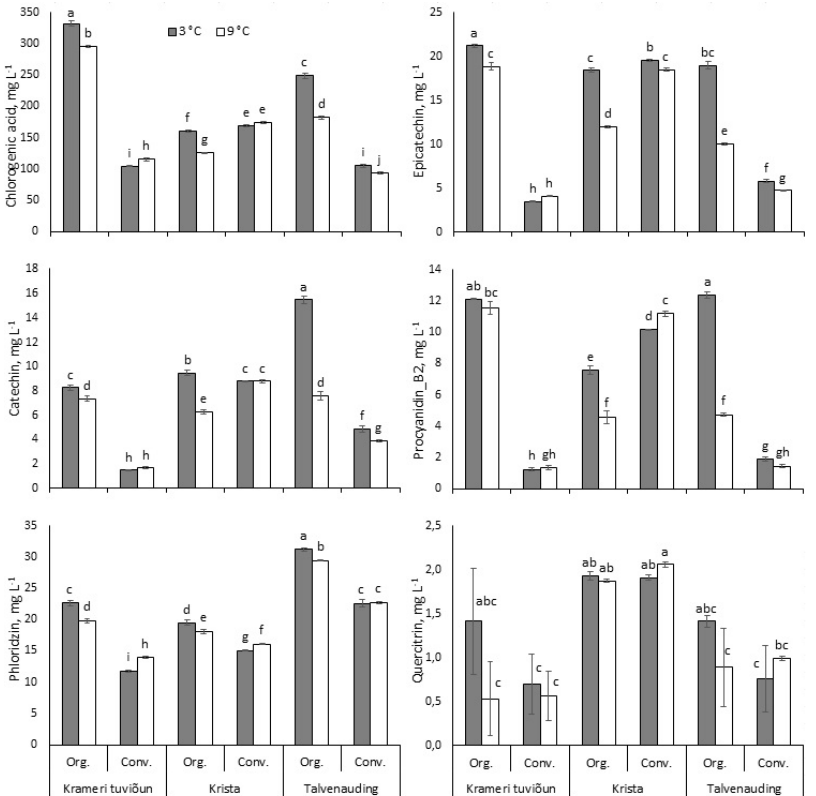
Fig. 1. Concentration of polyphenols in apple juice as affected by apple cultivation system (organic and conventional) and apple storage temperature before processing (3 and 9±2 ˚C) in Estonia in 2015. Values are means ± standard error, n = 3. Values with different letters are significantly different at p <